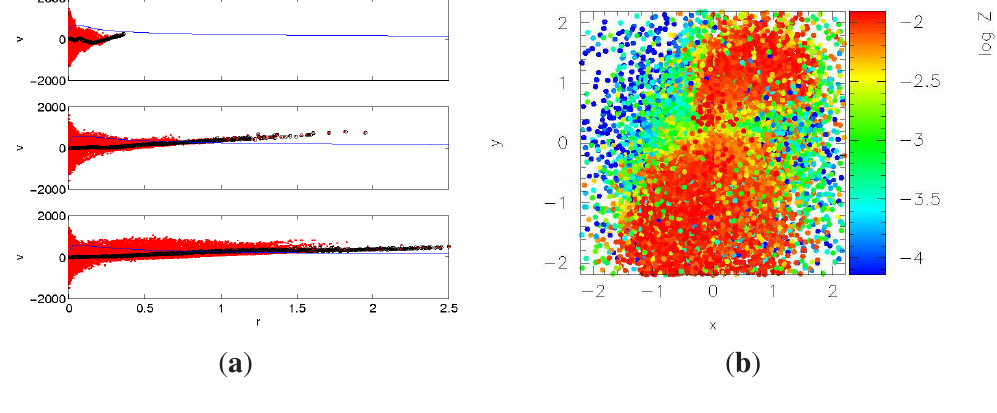
Figure 13. ( a ) Galactic winds in the HDHM model. Red points: radial velocities of gaseous particles (km/s) against the distance from the barycenter of the systems (Mpc). Black circles: mean radial velocity in the spherical shell at radius r . Solid blue line: escape velocity as a function of the radius. Top to bottom: z = 4 . 4 , 1, 0.2; ( b ) Projection on the [X,Y]-plane of the gas particles in the galactic winds. The color code is according to the metallicity of the gas particles. Nuclearly processed material can leave the galaxies thus enriching the surrounding medium. Reproduced with permission from [1]. Copyright 2012 John Wiley &